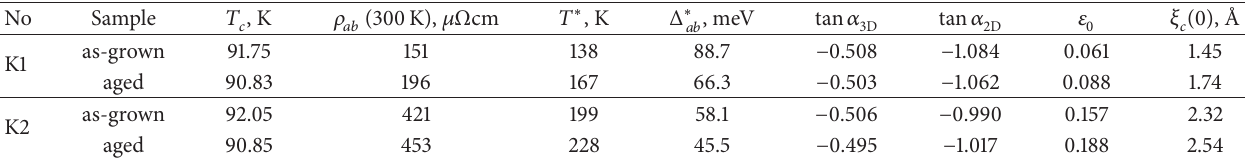
Figure2:Thetemperaturedependence 𝜌 𝑎𝑏 (𝑇) ofthesinglecrystals(a)YBa 2 Cu 3 O 7−𝛿 and(b)YBa 2 Cu 3−𝑦 Al 𝑦 O 7−𝛿 beforeandafterlongagingin ambient air, curves 1 and 2, respectively. The arrows show the mean-field transition temperature 𝑇 ∗ to the pseudogap regime. The extrapolated values of 𝜌 𝑎𝑏 (0 K ) are traced by the dashed straight lines. The insets show the superconducting transitions in 𝜌 𝑎𝑏 - 𝑇 and 𝑑𝜌 𝑎𝑏 /𝑑𝑇 - 𝑇 coordinates for the same samples. The numbering of the curves in the insets corresponds to that in the main panels. Table 1: Resistivity parameters of the as-grown and aged